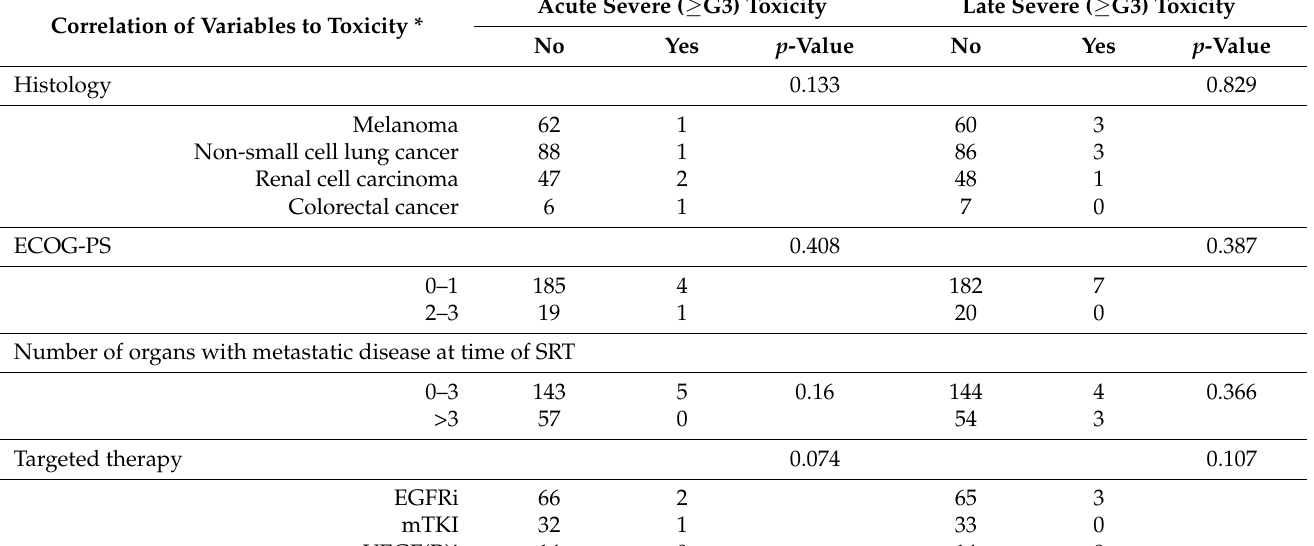
Table 2. Correlation of clinical variables to the presence of severe (CTCAE v4.03 ≥ G3) toxicity present. Acute toxicity is ≤ 3 months after stereotactic radiotherapy (SRT), late toxicity is >3 months after